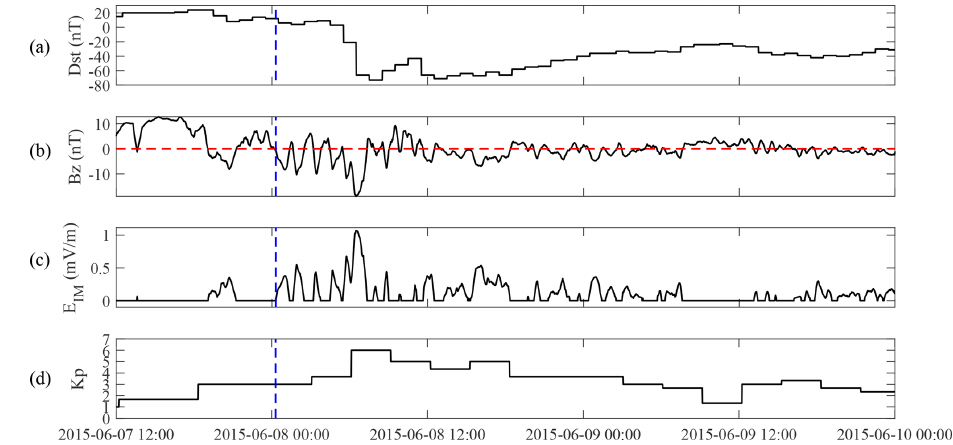
Figure 9. The indices of geomagnetic activity and solar wind during the geomagnetic storm that occurred in the time interval of 8– 10 June 2015; the format is the same as that in Fig. 7.